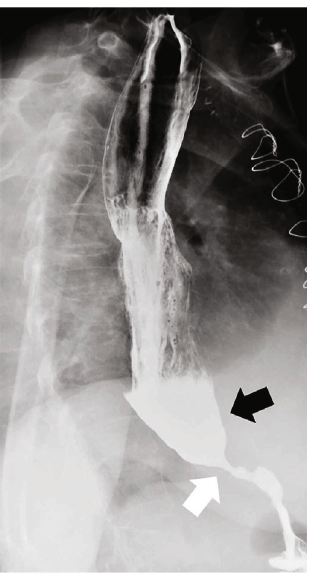
Figure 4: Barium swallow study demonstrating achalasia. There is signi fi cant narrowing at the lower esophageal sphincter (white arrow) with pooling of contrast in the distal esophagus (black arrow) and markedly delayed transit of contrast into the